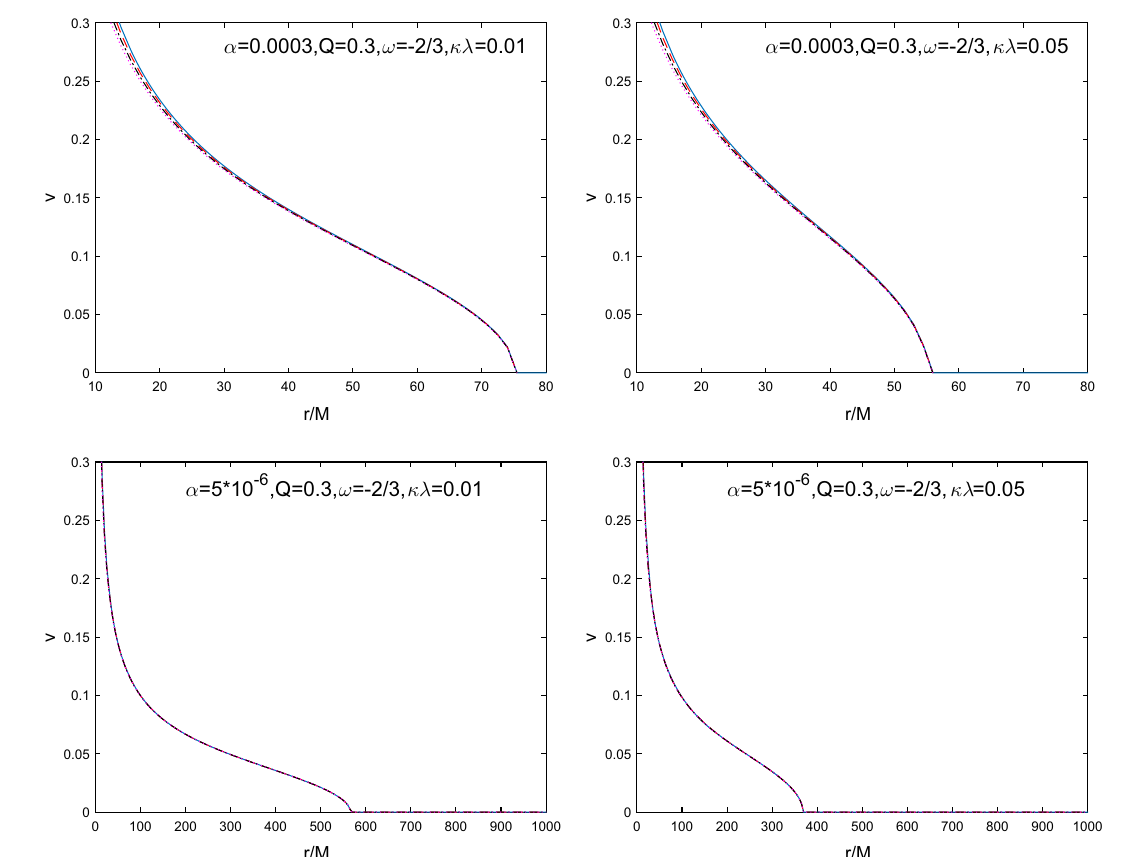
Fig. 3 Curves of the rotation velocity for the KN-AdS black hole surrounded by the dark energy in the Rastall gravity − g t φ, r (cid:11) φ =